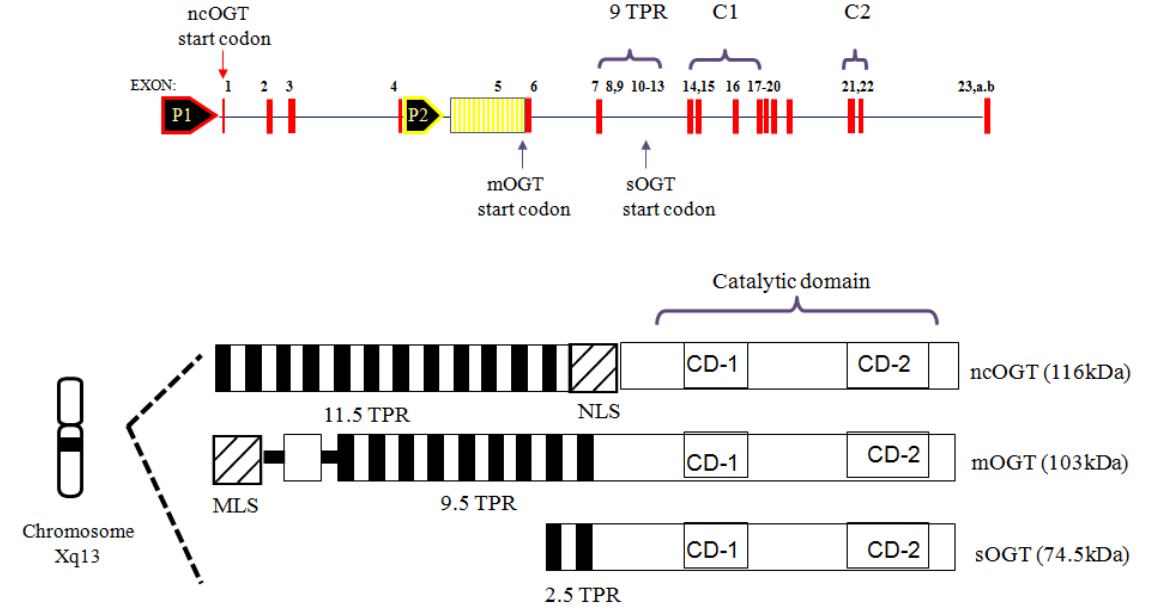
Figure 11. Human OGT